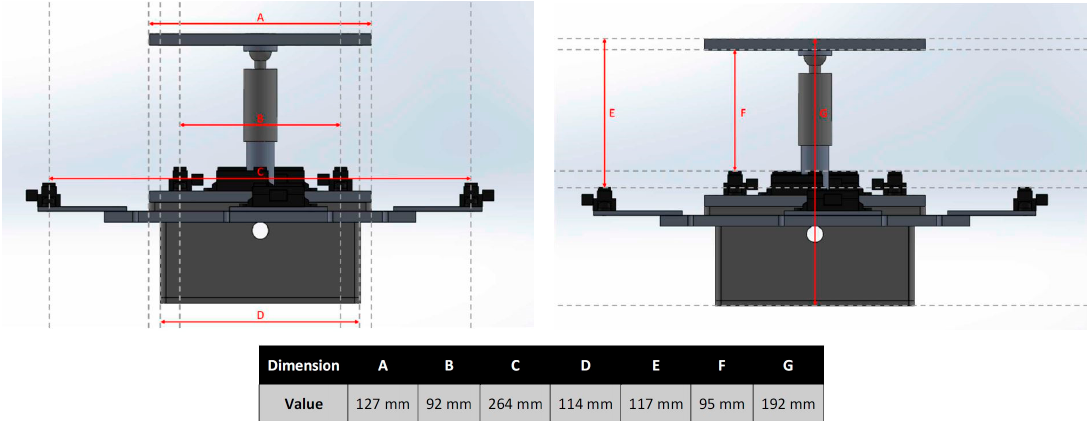
Figure 5. Instrumented compliance wrist physical dimensions.